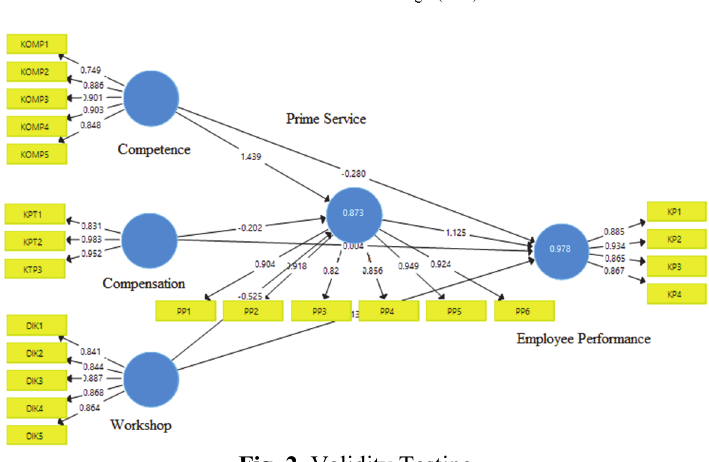
Fig. 2. Validity Testing